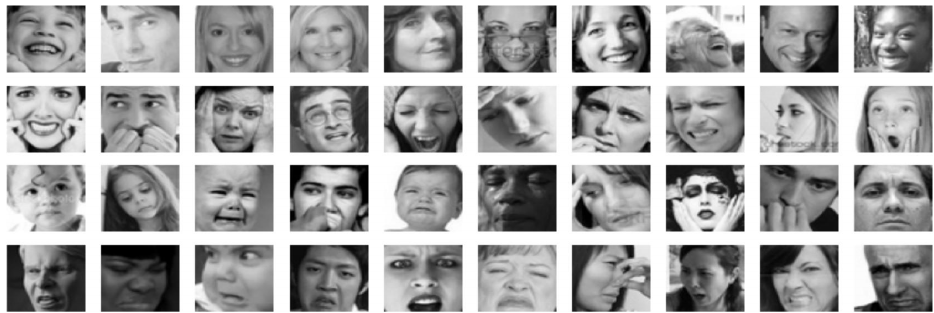
Figure 1. Samples from the FER-2013 dataset.